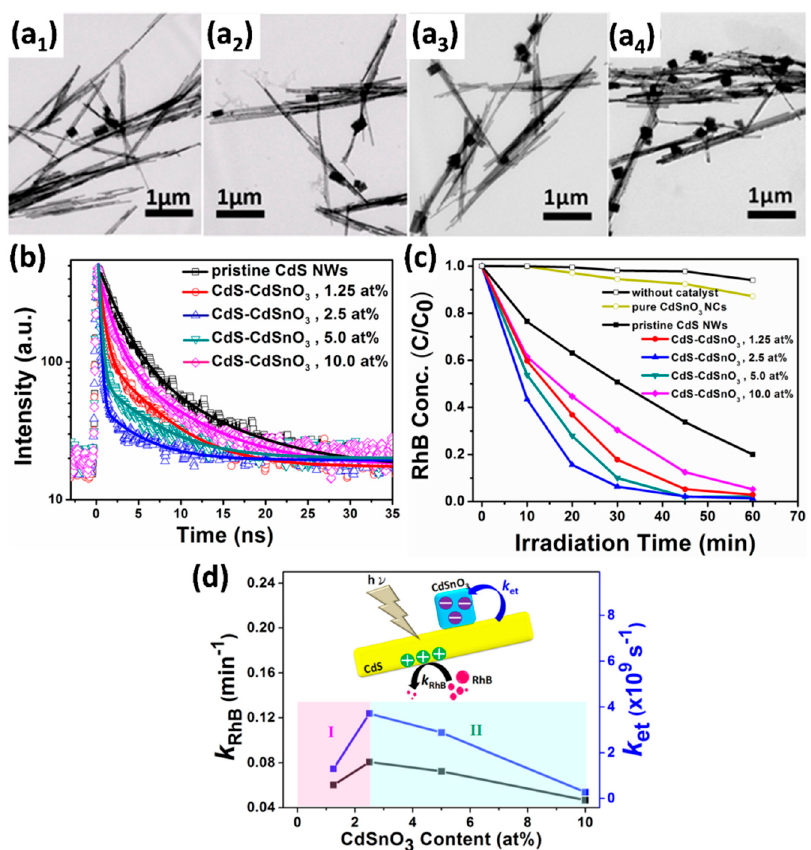
Figure 13. ( a1–a4 ) TEM images for CdS–CdSnO 3 with increasing CdSnO 3 content from 1.25 at.% to 10.0 at.%. ( b ) TRPL analysis. ( c ) RhB photodegradation under visible irradiation and ( d ) correlations